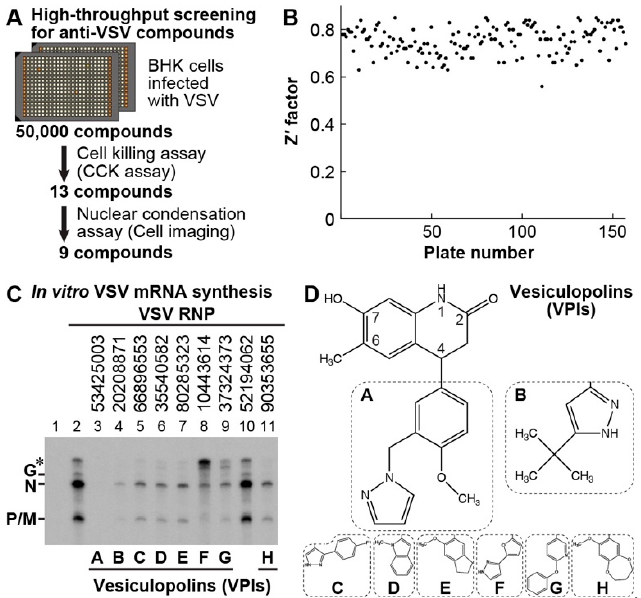
Figure 1. Screening for anti-VSV compounds. A flow diagram of screening for anti-VSV compounds is shown in ( A ). High-throughput screening of the ChemBridge library composed of 50,000 small molecules was performed for compounds that rescue cells from VSV-induced CPEs (metabolic shut-down and nuclear condensation). BHK-21 cells were mock-infected or infected with VSV at an MOI of 0.1 in the presence or absence of each compound (~17 µM) and cultured for 24 h. VSV-induced metabolic shut-down was measured as a decrease in cellular dehydrogenase activities by a colorimetric cell viability assay with the CCK-8 reagent (CCK assay). As described in Section 2.3, the Z ′ factor for each plate was calculated ( B ). After fixing and staining the cells, cell nuclei were analyzed by an automated cell imaging system. Compounds displaying ≥ 30% inhibition of VSV-induced metabolic shut-down and nuclear condensation were selected as primary hits. In vitro mRNA synthesis was performed with VSV RNP in the presence or absence of the hit compounds (20 µM) ( C ). Deadenylated mRNAs were analyzed by 5% urea-PAGE followed by autoradiography. Lane 1 indicates no RNP. Eight-digit ChemBridge identification numbers for the hit compounds are shown above the lanes. The positions of the VSV mRNAs (N, P/M, and G) are indicated. Unknown transcripts of 2–3 kilo nt in length are marked by an asterisk. Eight structurally related compounds (named vesiculopolins, VPI A–H) were identified as VSV RdRp inhibitors. VPIs have a common structure [7-hydroxy-6-methyl-3,4-dihydroquinolin-2(1H)-one] with a variable group at position 4 ( D ). The chemical structure of VPI A is shown as a representative. For VPIs B–H, only substituent groups at position 4 are shown.